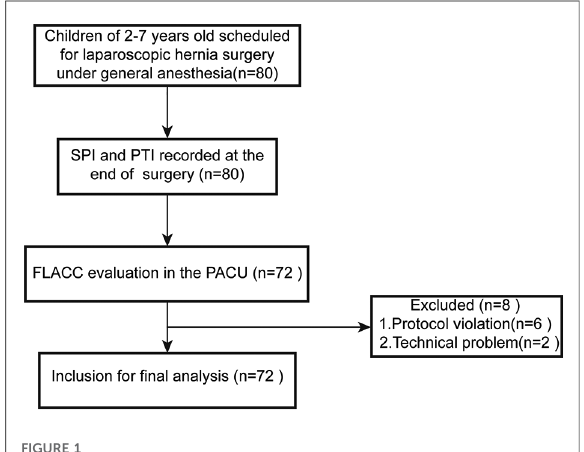
FIGURE 1 Flow diagram of the study protocol. SPI, surgical pleth index; PTI, pain threshold index; PACU, post-anesthesia care